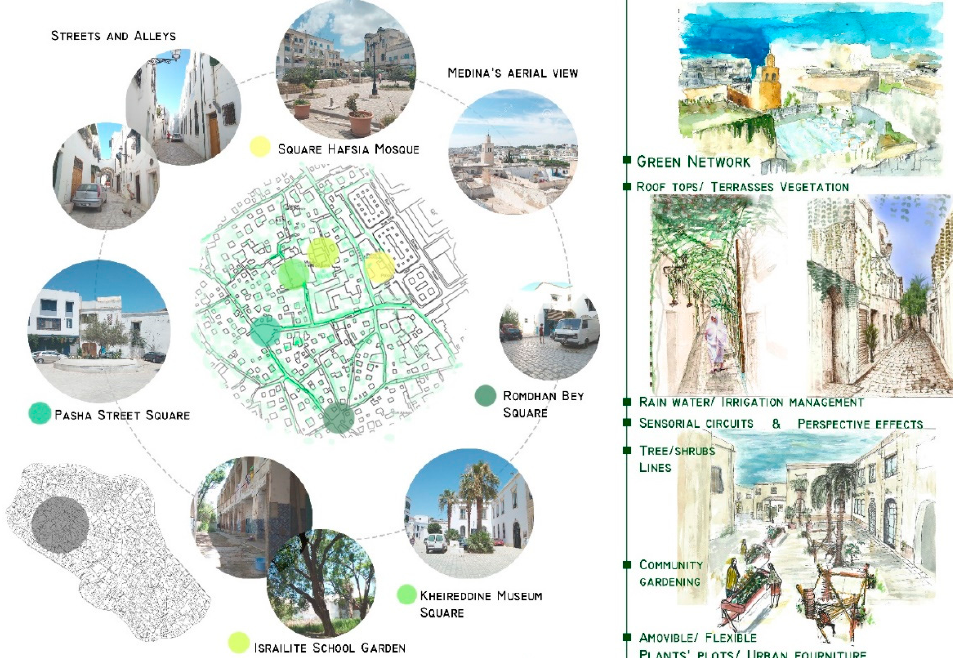
Figure 14. Plan and proposal to improve the selected area in the Medina of Tunis by implementing and enhancing UGI elements (data source: Authors photographs and sketches). Table 1. Design proposals in the study